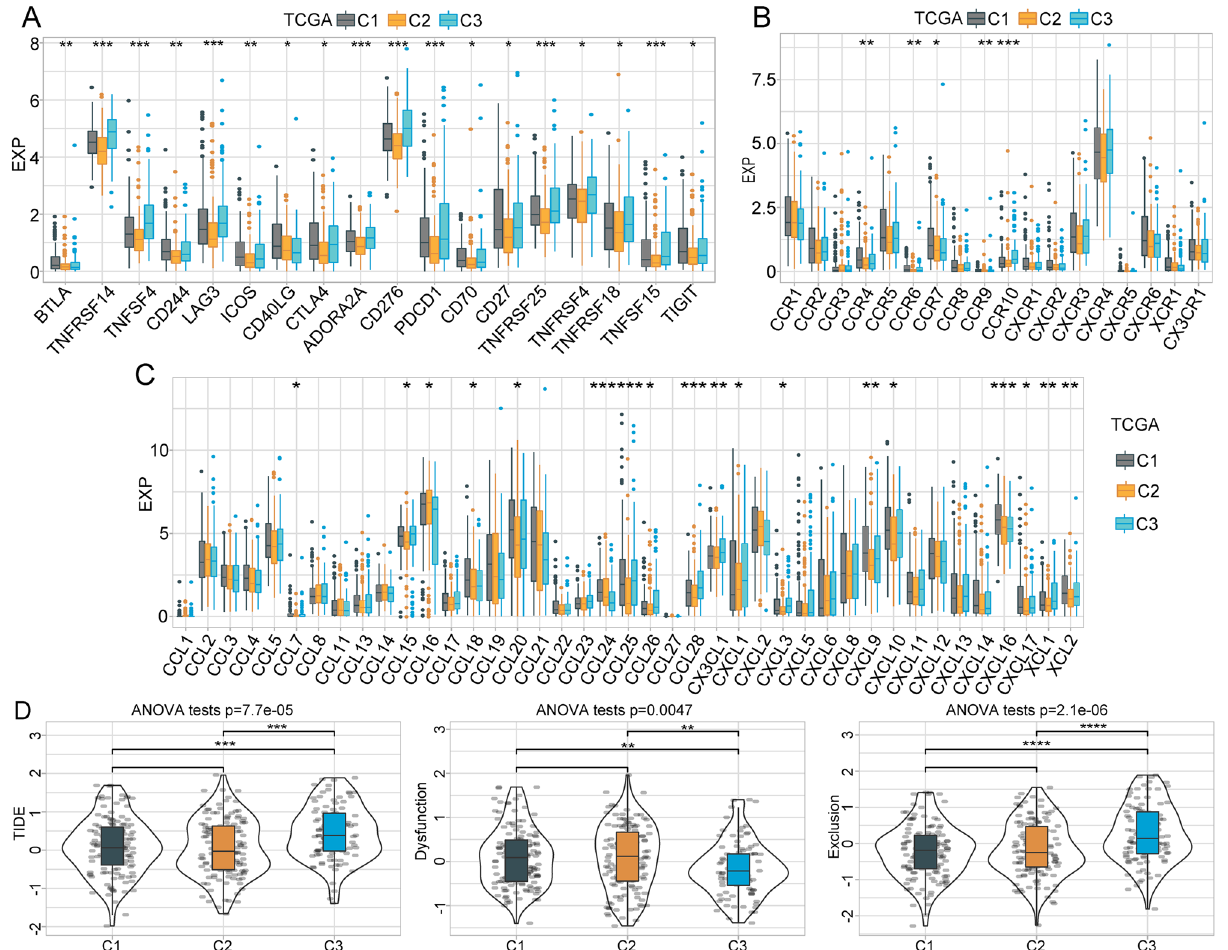
Figure 6. Immunotherapy differences in molecular subtypes. ( A ) Differential distribution of immune checkpoint expression across subtypes from the TCGA. ( B , C ) Differences in chemokine and chemokine receptor expression across subtypes in the TCGA. ( D ) Differences in TIDE and CAF scores and survival for TCGA immunotherapy